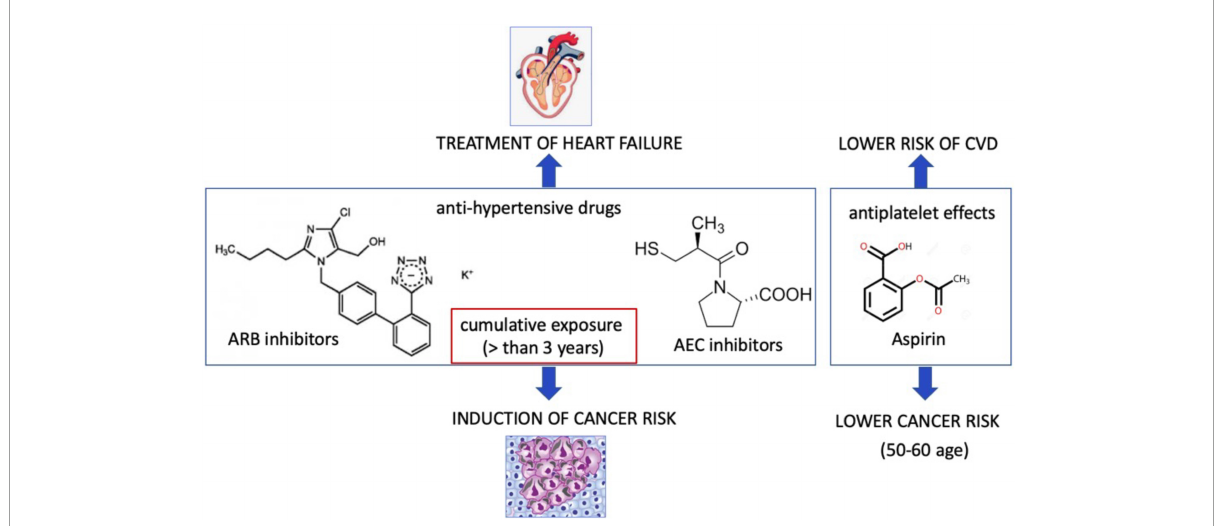
FIGURE2 Cardiovascular drugs may promote or suppress cancer incidence. Angiotensin receptor II blocker that are used for treatment of hypertension at the cumulative exposure more than 3 years may induce cancer risk. Aspirin may lower cancer risk.